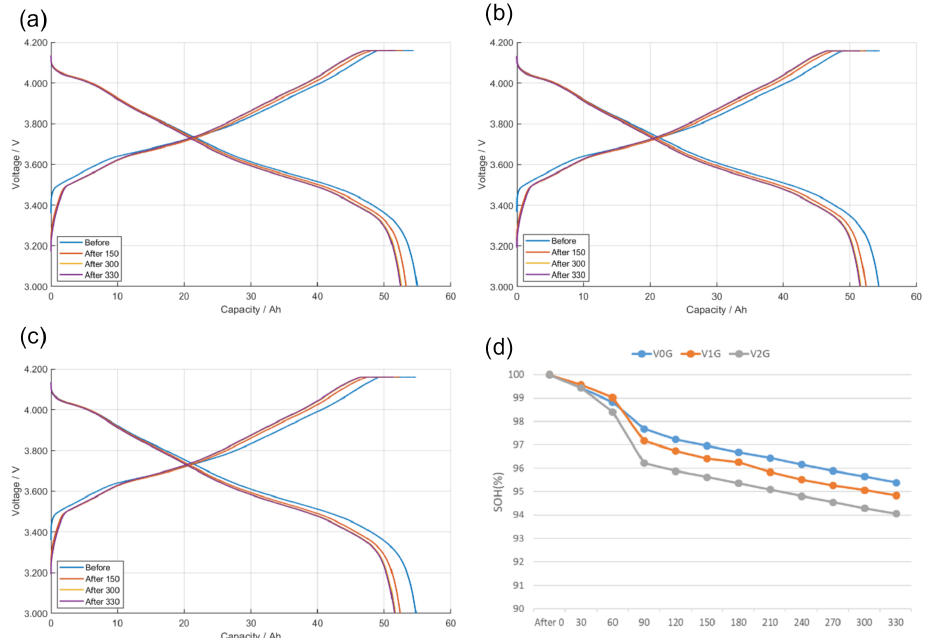
Figure 4. Post-pattern battery performance test: Capacity. ( a ) Capacity after V0G pattern, ( b ) Capacity after V1G pattern, ( c ) Capacity after V2G pattern, ( d ) Comparison of capacity between V0G, V1G, and V2G patterns.